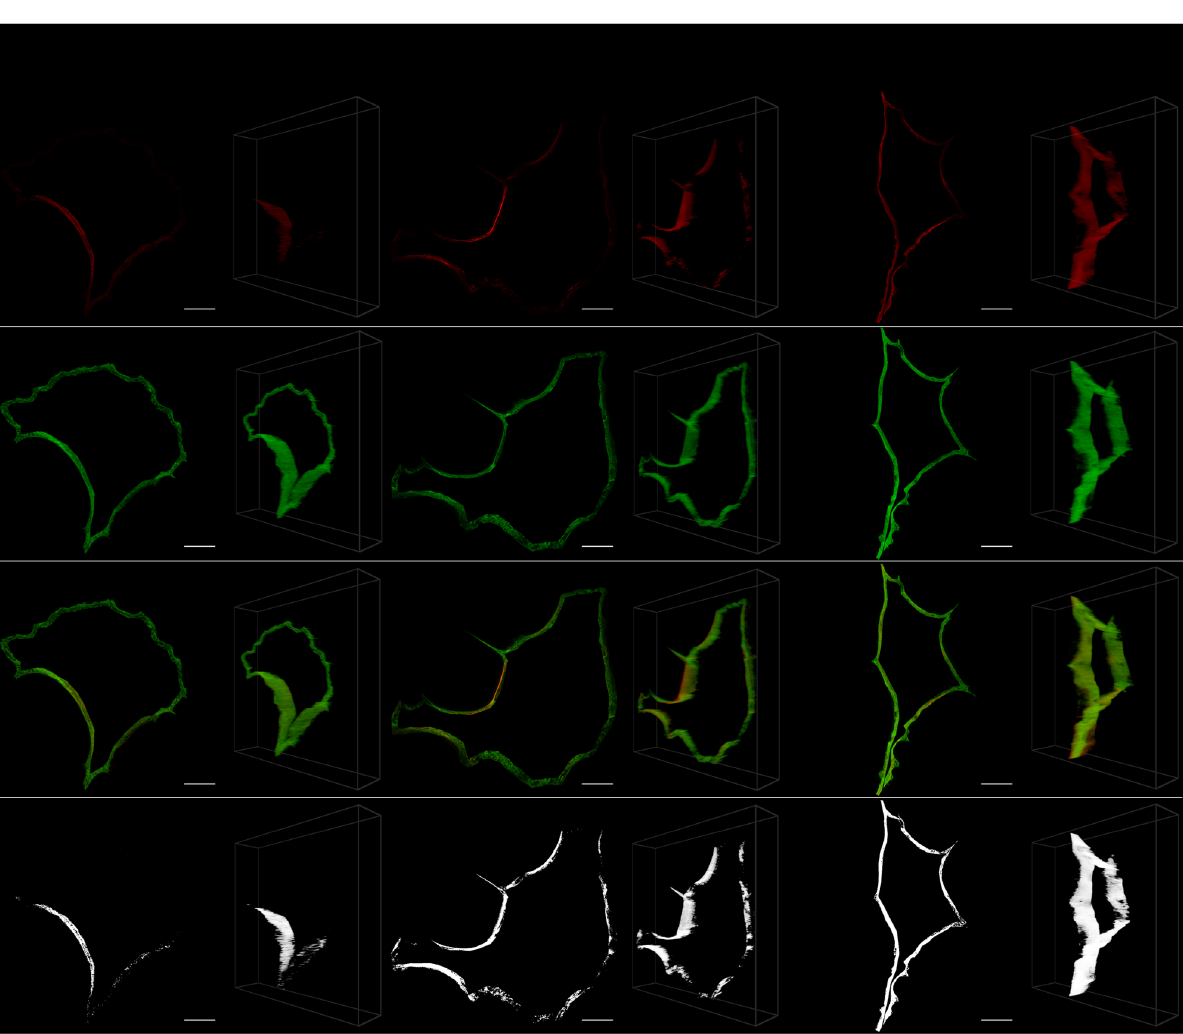
Fig 5. Freehand membrane region. Representative cells for each considered time ( t = 0, t = 6, t = 24) with the maximum intensity projection on the left and the 45˚ 3D view on the right. Shown from top to bottom are the acetylated α -tubulin (red), the Tau (green), the tubulin and Tau overlaid, and only the colocalized